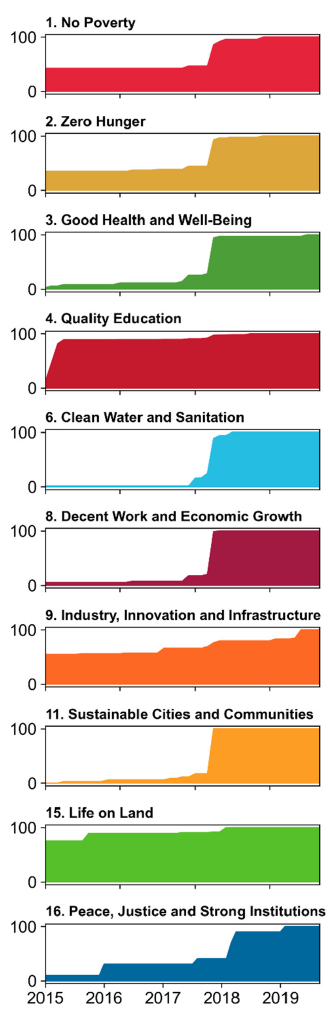
Figure 14. Monthly calendar heatmaps of ( a ) V1 creation dates and ( b ) Vn terminal version dates for SDG-relevant features in non-refugee settlements. Counts are presented on a logarithmic scale.